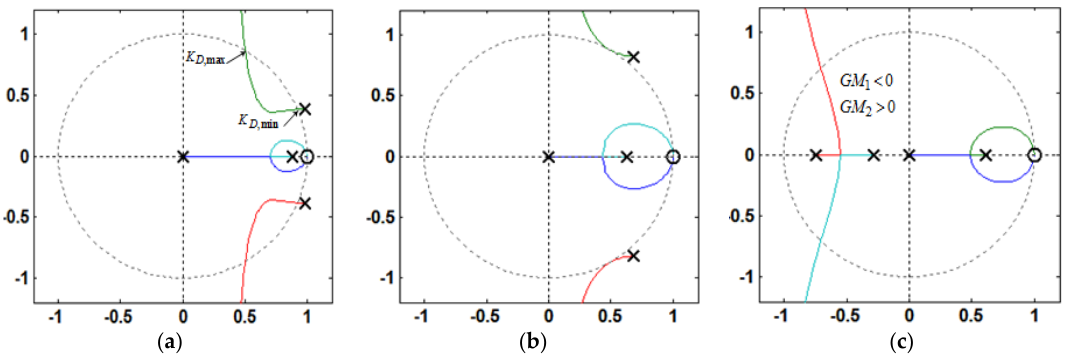
Figure 12. Root loci of the digital single-loop current control with proportional CCF AD method with variation of damping gain K D for a fixed K P value: ( a ) low resonant frequency region ( f res < f s /6; C f = 36 μ F; K P = 0.0261); ( b ) critical resonant frequency ( f res = f s /6; C f = 5 μ F; K P = 0.07); and ( c ) high resonant frequency region ( f res > f s /6; C f = 1 μ F; K p = 0.116).